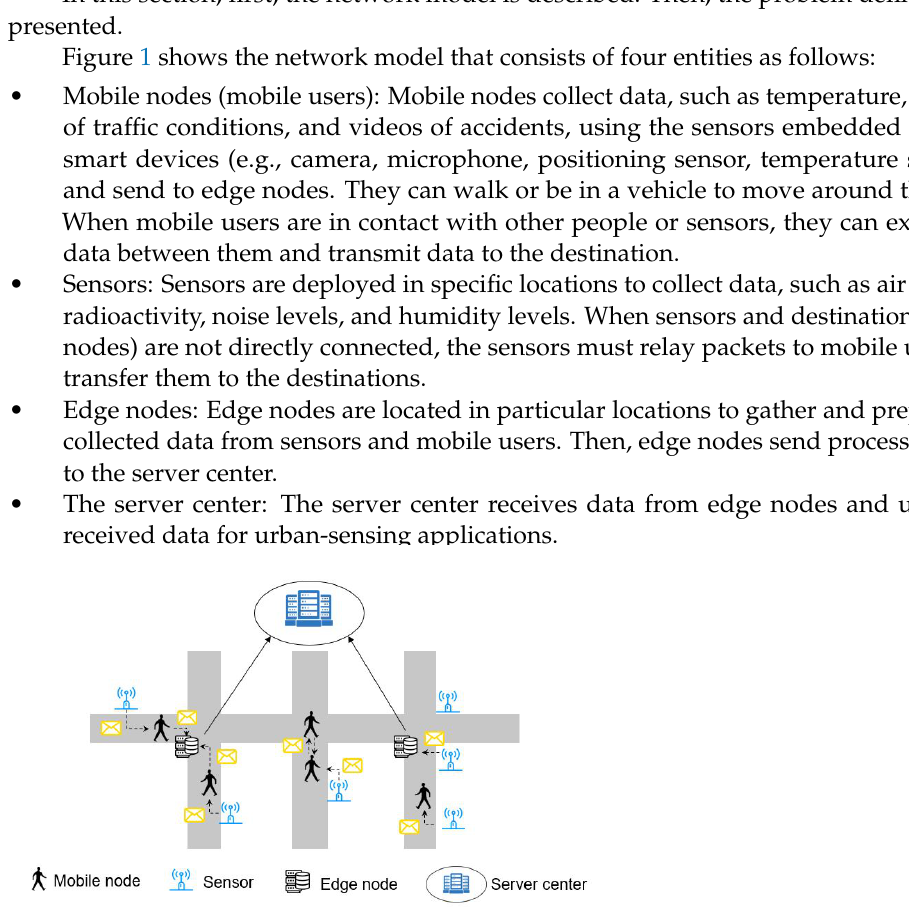
Figure 1. The network